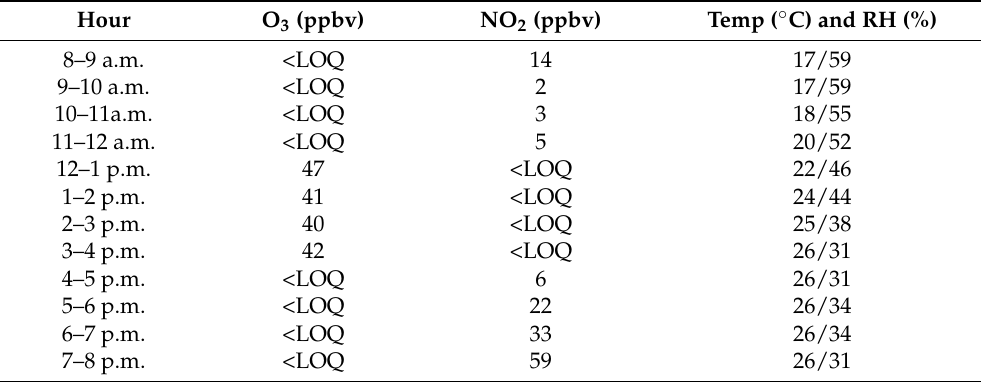
Table 5. Concentration levels obtained by the proposed platform for the monitoring of O 3 and NO 2 in the atmosphere of Uberl â